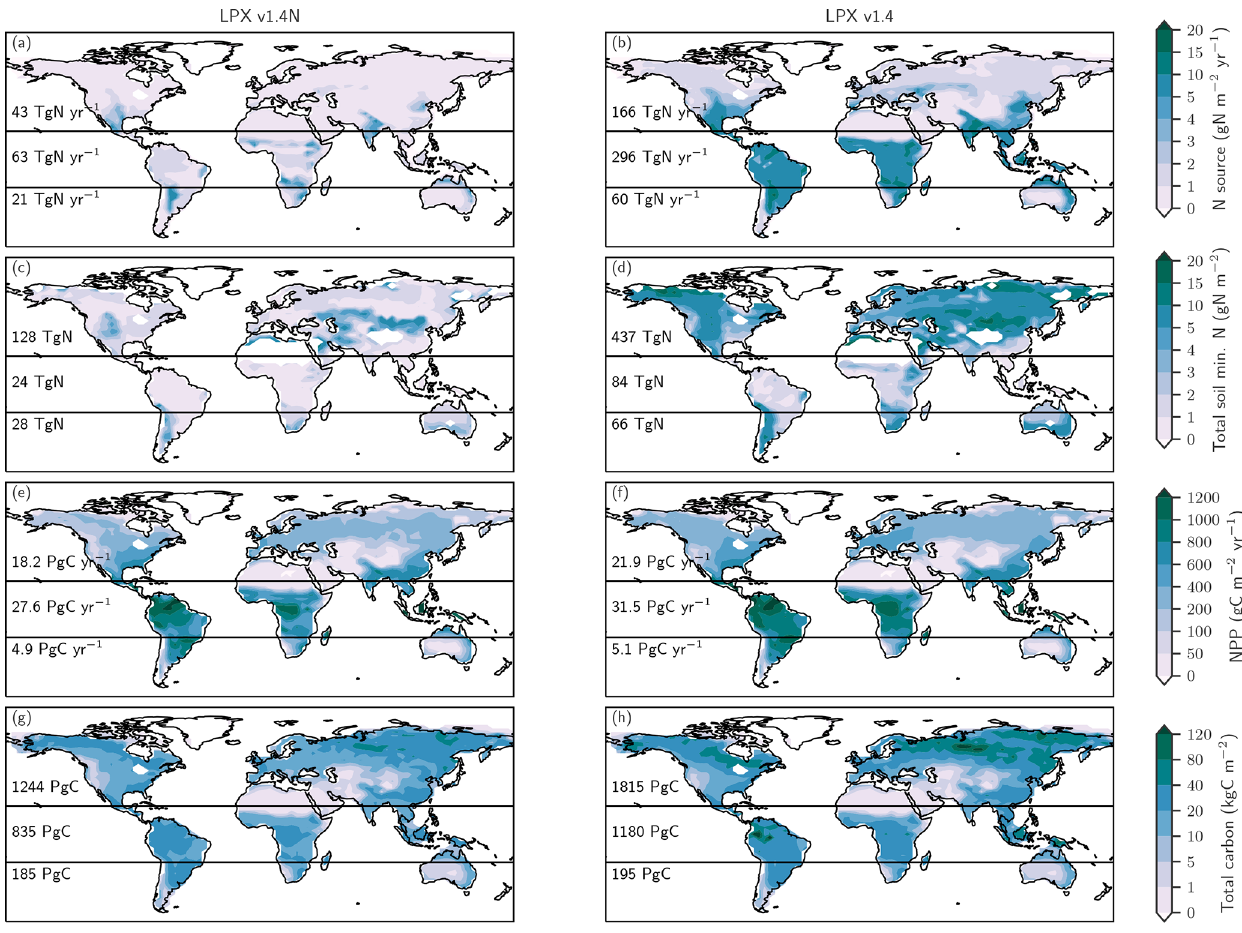
Figure A1. Comparison of model version LPX-Bern v1.4N (left) versus version v1.4 (right) for the preindustrial (0.5ka) patterns in the implied N source (a, b) , bioavailable concentrations of ammo- nium and nitrate in soils (c, d) , net primary productivity (e, f) , and total carbon (g, h)